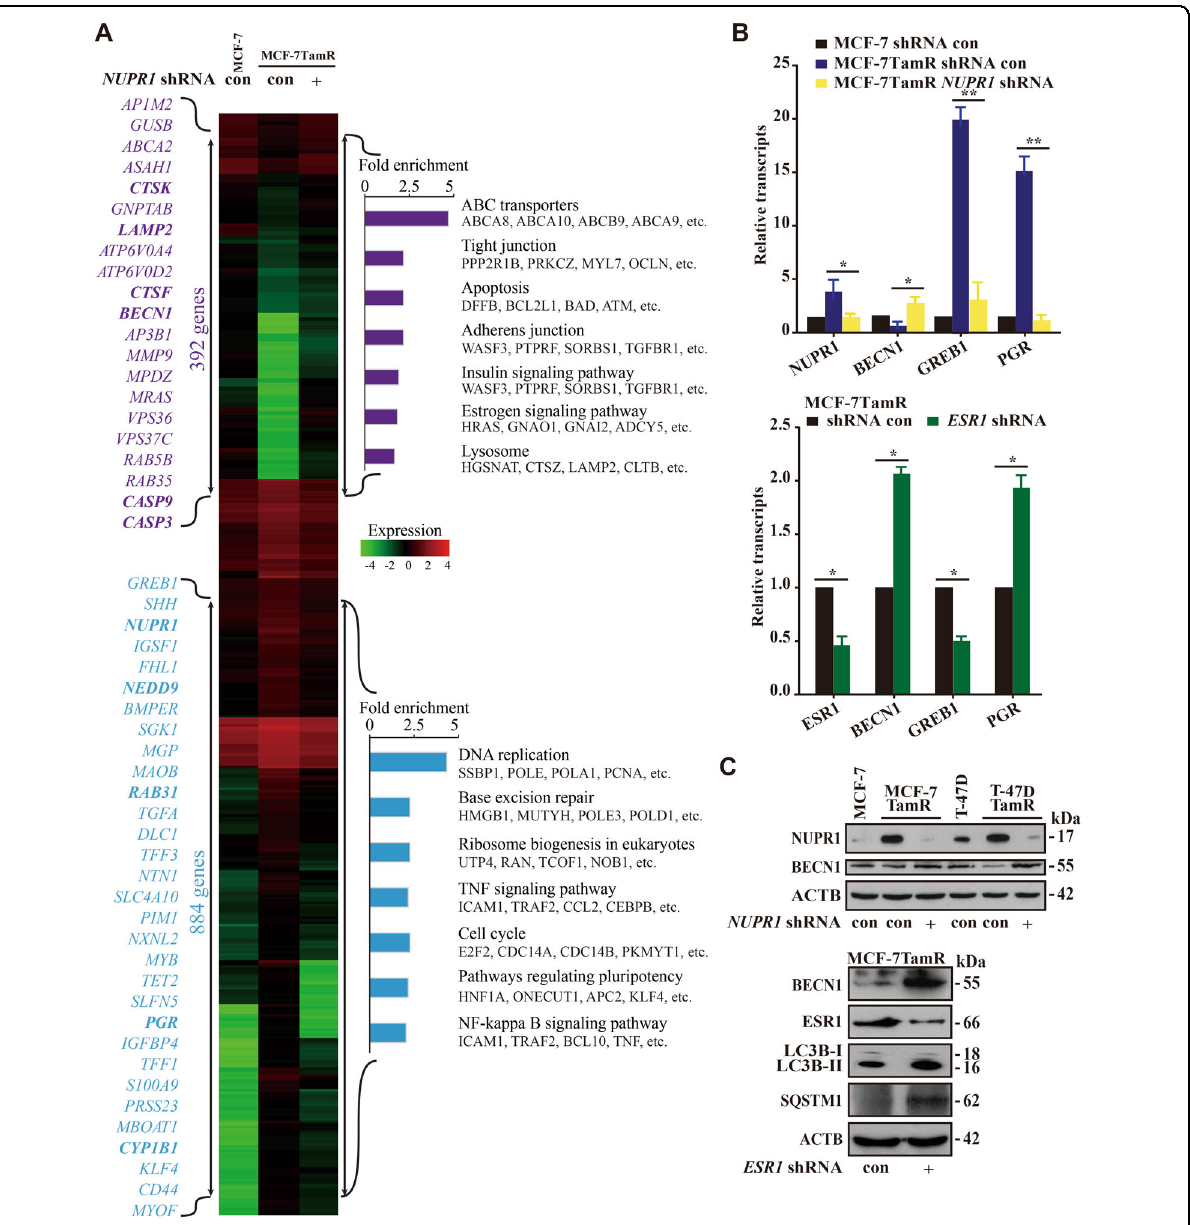
Fig. 6 A NUPR1-regulated gene signature is both prognostic and predictive for breast cancer. A Functional pro fi ling of genes differentially expressed between MCF-7TamR NUPR1 -depleted and MCF-7TamR shRNA con cells as well as the parental MCF-7 cells. Representative upregulated (purple) and downregulated genes (light blue) upon NUPR1 depletion are listed vertically (left) and under each molecular pathway (right). B The transcriptional levels of BECN1 , GREB1 , and PGR were con fi rmed by quantitative RT-PCR. The expression is shown as fold differences relative to GAPDH expression, compared to the levels in shRNA con samples. The mean ± SD of three replicates is shown ( n = 3). C Immunoblot of BECN1, NUPR1, LC3B, SQSTM1 and ESR1 in NUPR1 - or ESR1 -depleted cells as indicated, with ACTB as a loading